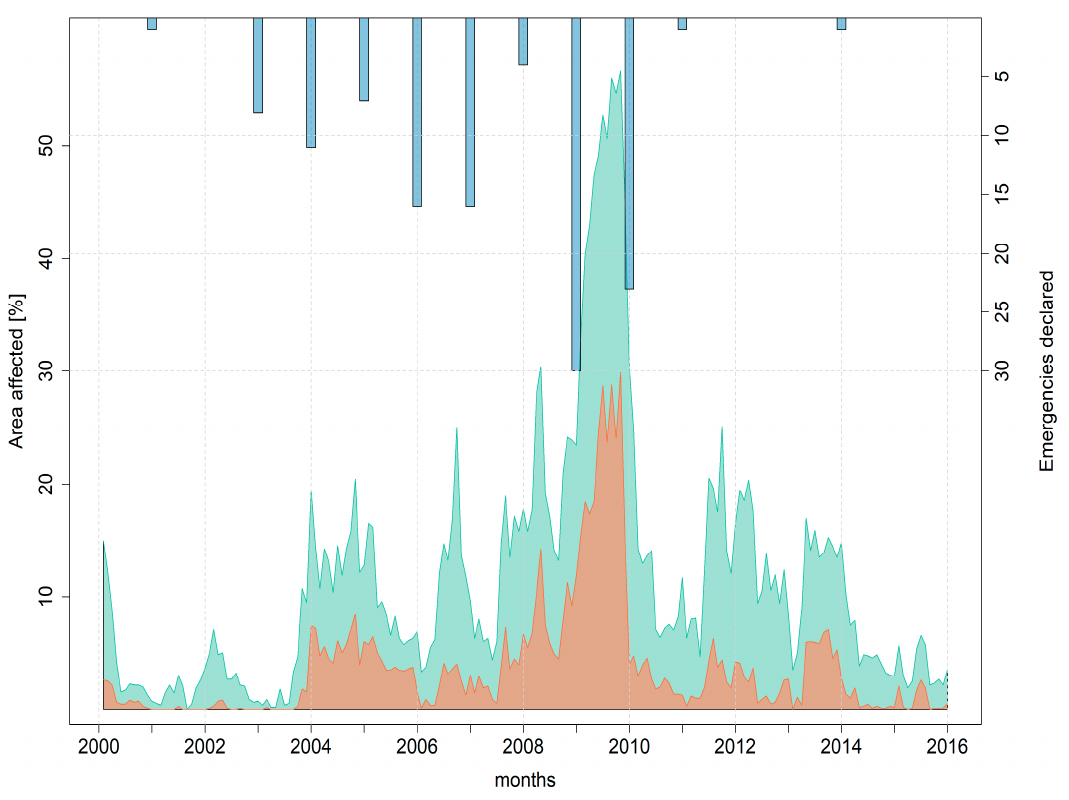
Figure 2. Percent of total land area in Argentina affected by moderate and severe droughts and number of farming emergencies officially declared (blue bars).